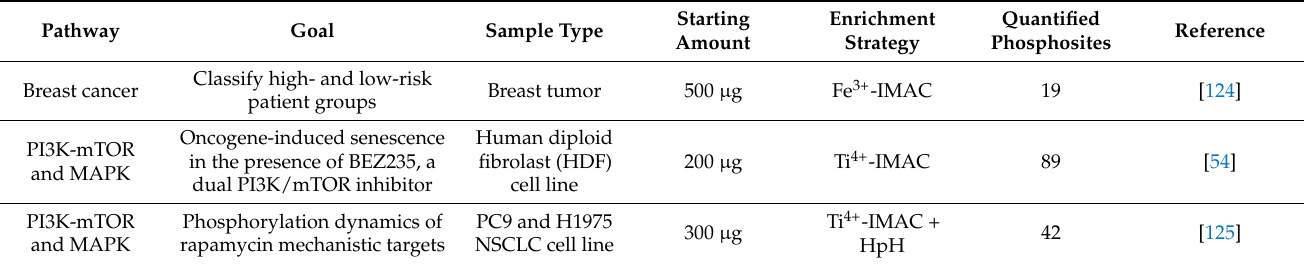
Table 1. Select studies that have demonstrated the use of targeted phosphoproteomics to quantify phosphorylation dynamics of signaling